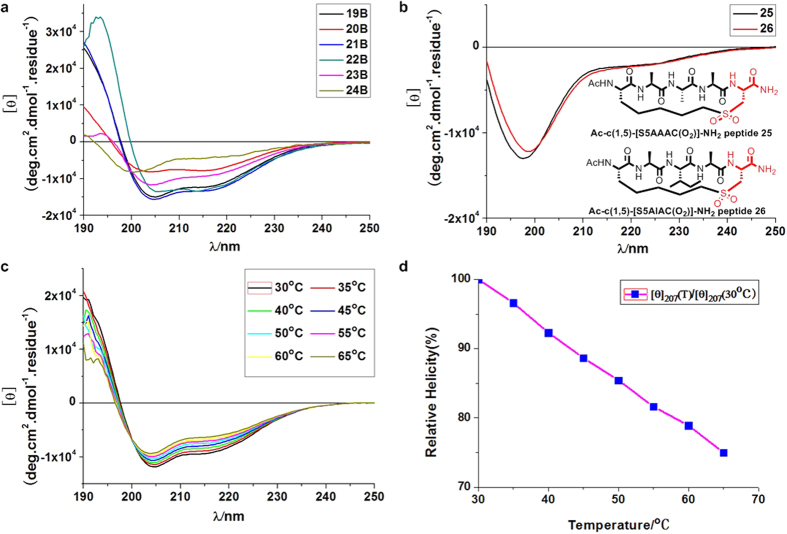
(a) CD spectra of (R)-diastereomer 19B-24B. (b) CD spectra of sulfone-containing peptides 25 and 26 show minimal helix contents. (c) CD spectroscopy was performed for (R)-19B at increasing temperatures. Its helicity decreased slightly as temperature increased (d) At 65 °C, (R)-19B retained 75% of the helicity that it showed at 30 °C. CD spectroscopy was performed in 10 mM PBS (pH = 7.4) buffer at 25 °C.